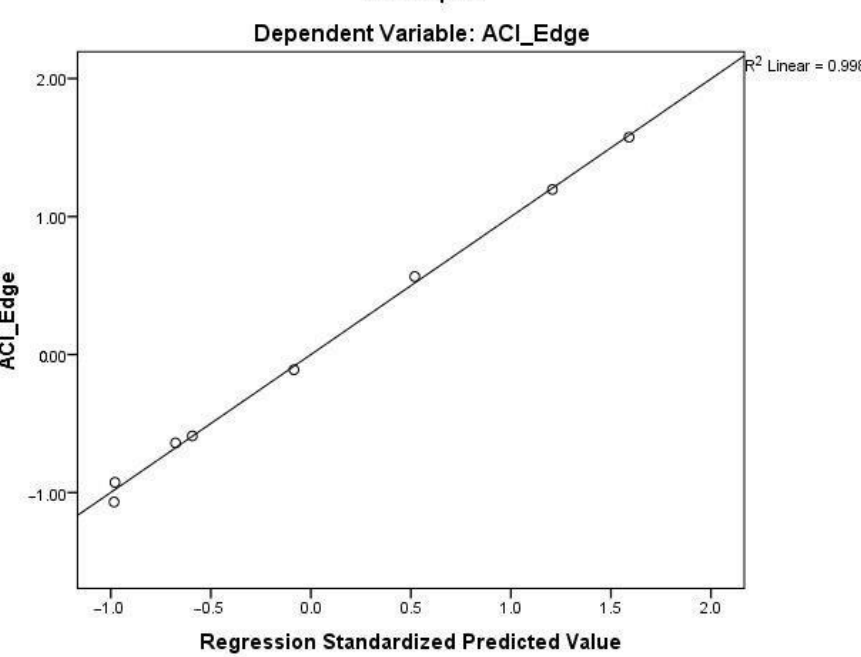
Figure 4. Regression standardized predicted value of acoustic complexity index levels of the area’s edges. area’s